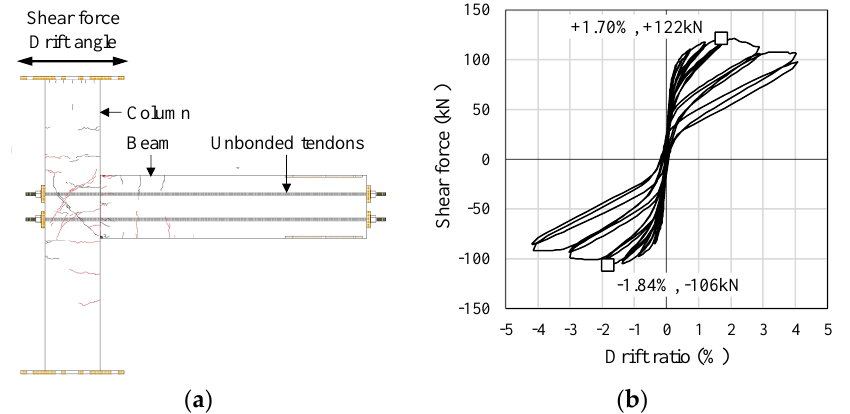
Figure 1. Test result of PC beam − column connection subassemblage: ( a ) damage map after loading to 2.0% of drift angle; ( b ) load − deformation diagram.